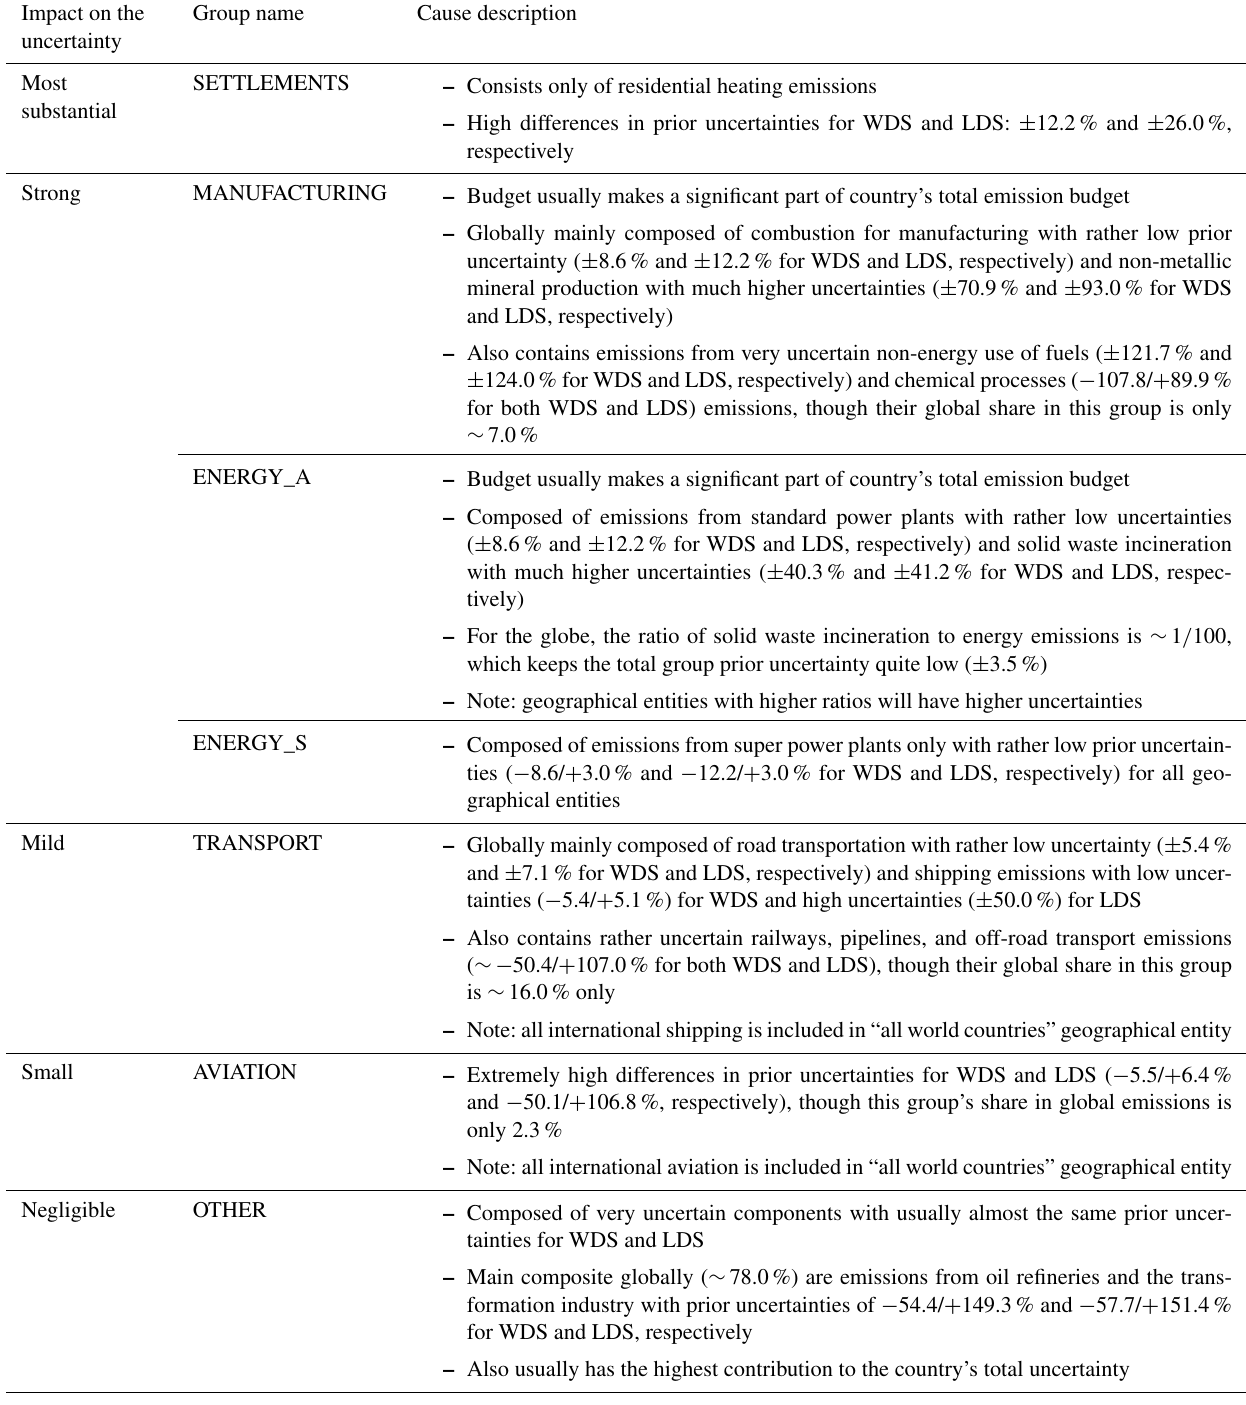
Table 7. Influence of country’s statistical infrastructure (countries with well- and less well-developed statistical infrastructures – WDSs and LDSs, respectively) on emission